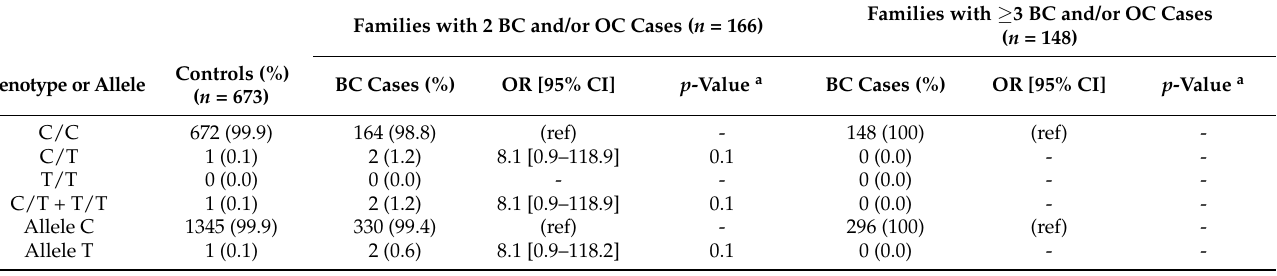
Table 2. Genotype and allele frequencies of rs144567652 ( FANCM ) according to the number of BC cases per family in BRCA1/2-negative breast cancer cases and